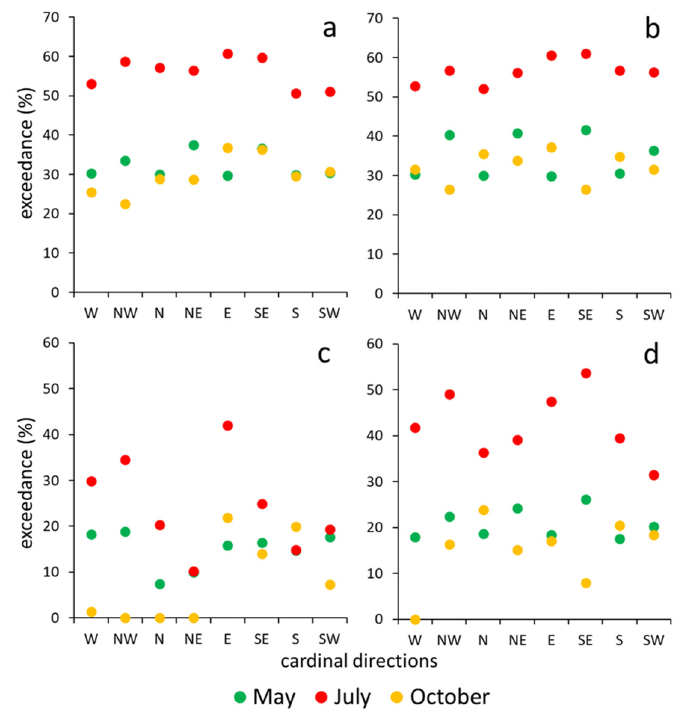
Figure 5. Exceedance rates for VPD values with respect to 1.2 kPa (top panels: ( a ), ( b )) and 3.0 kPa (lower panels: ( c ), ( d )) from 24-hour period of three measurement periods; ( a ) and ( c ): edge positions; ( b ) and ( d ): grassland end positions.